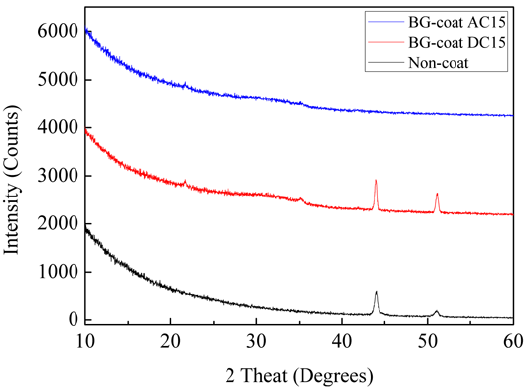
Figure 3. Representative X ‐ ray diffraction (XRD) spectra of the non ‐ and BG ‐ coated specimens.